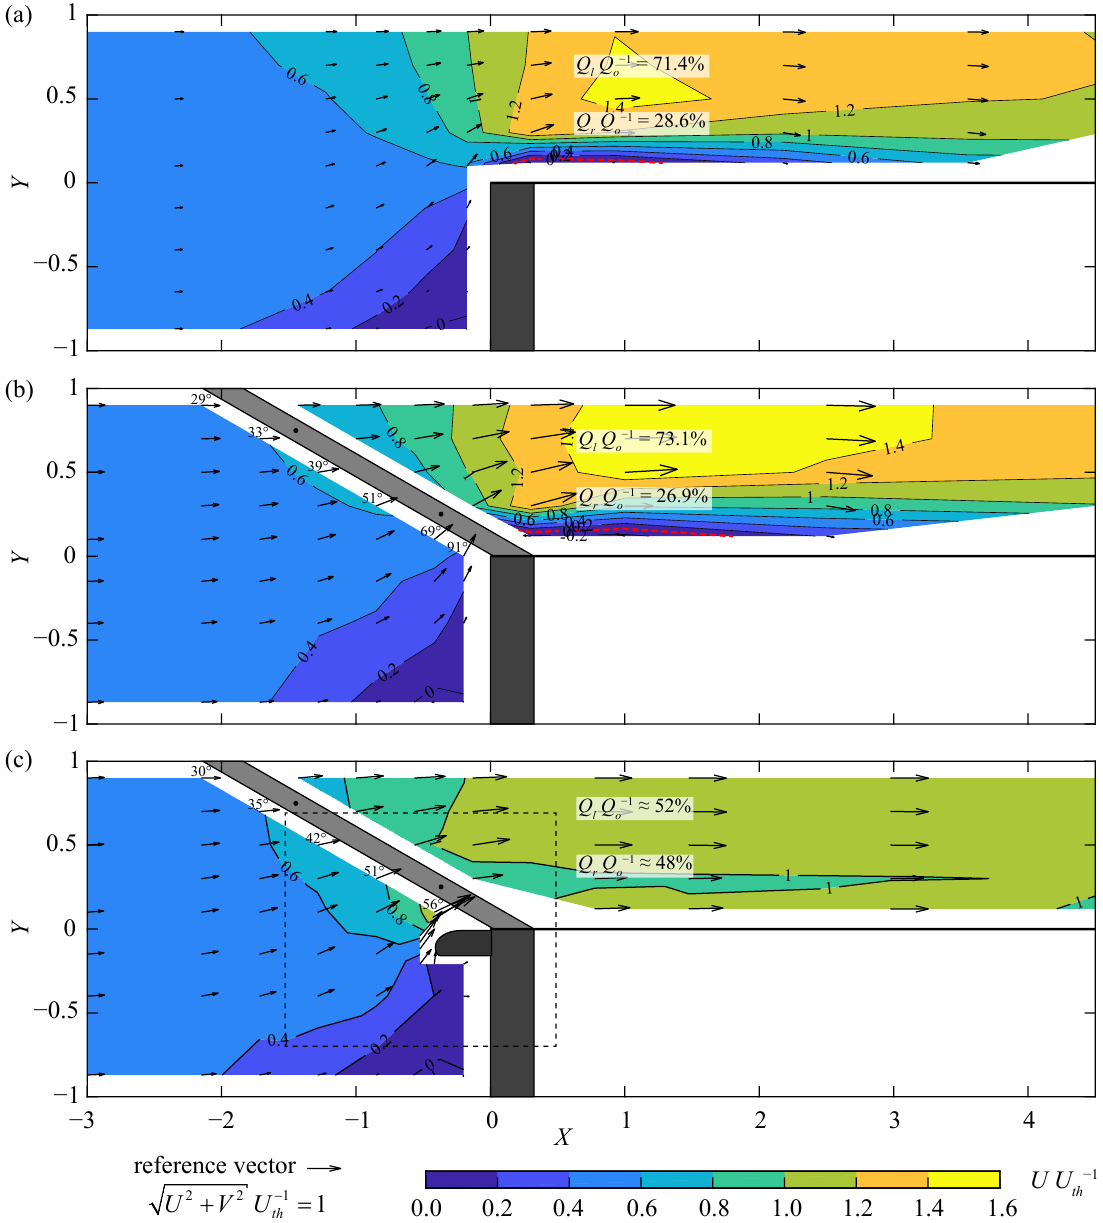
Figure 12. Normalized velocity field at block-type hydropower plant configurations ( a ) without rack (contraction head loss coe ffi cient ξ c = 0.29), ( b ) S4, α = 30 ◦ , s b = 20 mm, H Ov = 0 ( ξ c + ξ R = 0.64), and ( c ) S4, α = 30 ◦ , s b = 20 mm, H Ov = 0 with a dividing pier; dashed rectangle corresponds to field of view of Figure 13; the red dashed streamlines indicate the separation to the recirculation